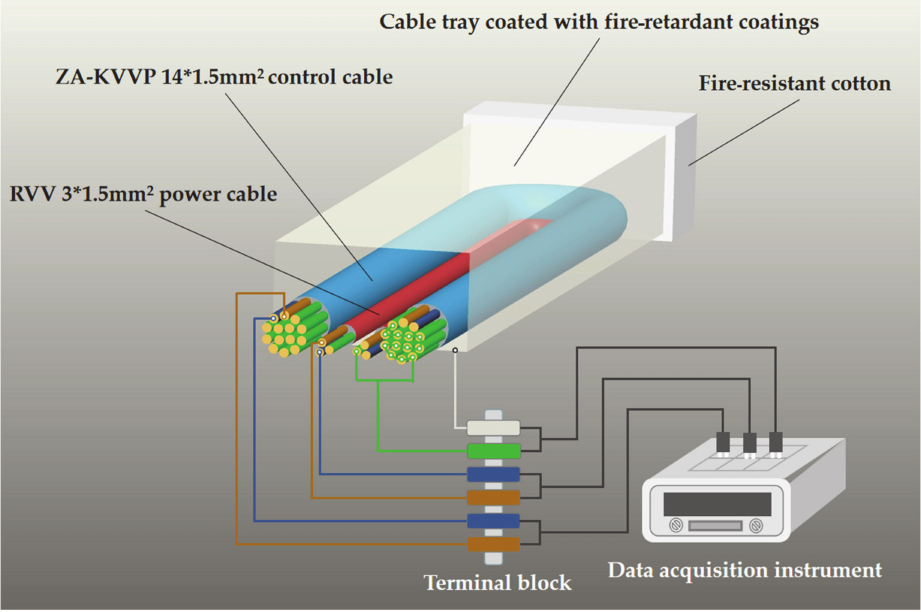
Figure 5. Wiring diagram of insulation resistance test